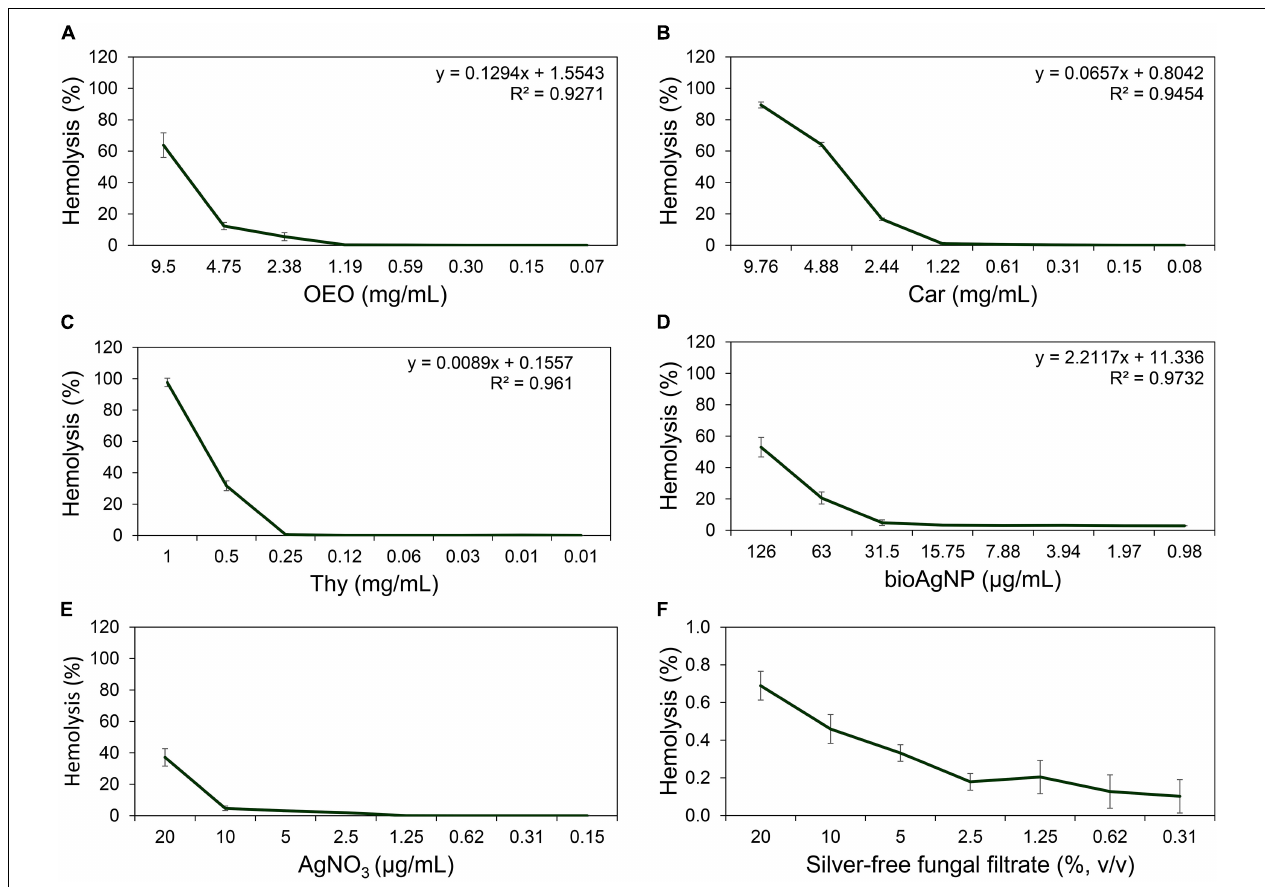
FIGURE 8 | Hemolytic activity at different concentrations of the oregano-derived antimicrobials and silver-based compounds individually. (A) OEO. (B) Car. (C) Thy. (D) BioAgNP. (E) AgNO 3 . (F) F. oxysporum -free solution used in bioAgNP synthesis. Maximum tested concentrations of the fungal-free solution and bioAgNP have equivalent volumes. Values of hemolysis percentage are the mean ± standard deviation. The linear model equation used to predict the CC 50 of each antimicrobial and its R-squared ( R 2 ) are